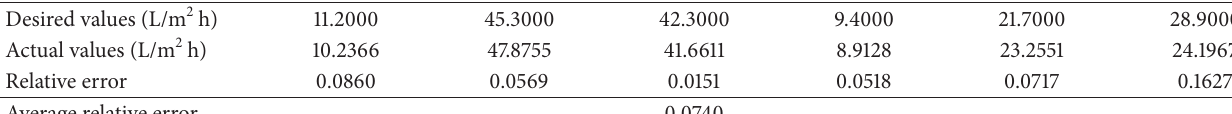
Table 2: Relative errors of membrane flux prediction of BP